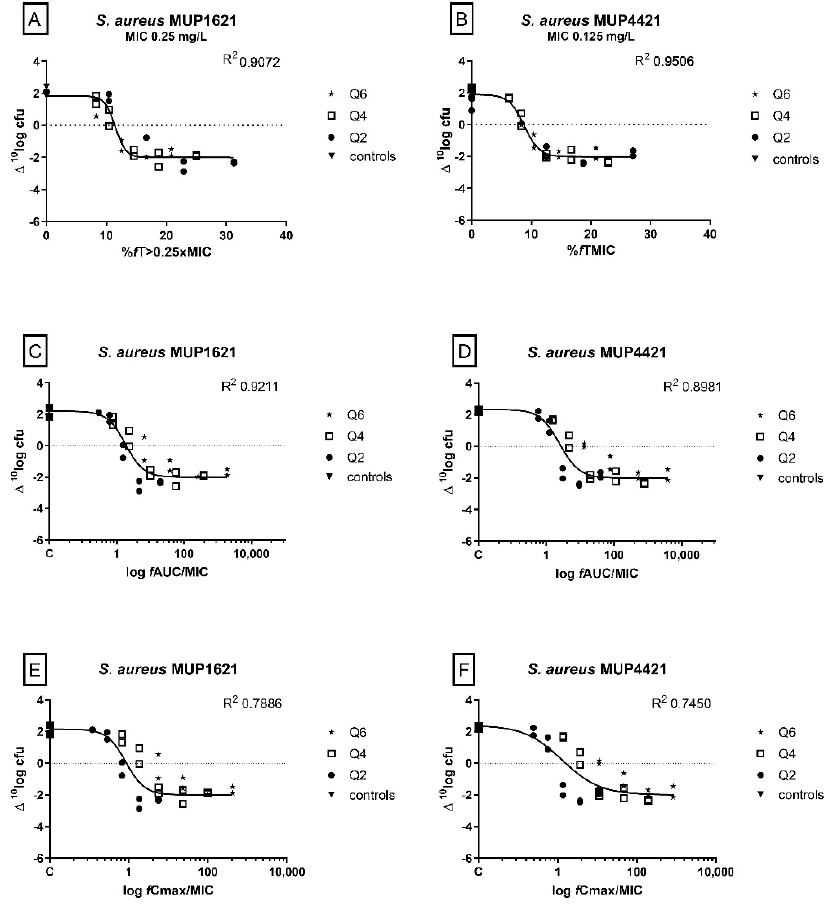
Figure 1. Relationships of flucloxacillin percentage of time the unbound concentration was above 0.25 times the MIC (% f T > 0.25xMIC) ( A ), % f T > MIC ( B ), 24 h f AUC/MIC ( C , D ), and f C max /MIC ( E , F ) for S. aureus MUP1621 and MUP4421 in the neutropenic thigh infection model, with change in CFU per thigh from start of treatment and after 24 h of treatments. Flucloxacillin was dosed every 2 (Q2), 4 (Q4), or 6 (Q6) h. Each symbol represents a therapy response in one mouse thigh. The line is the best-fit line based on the sigmoid maximum effect (E max ) model.